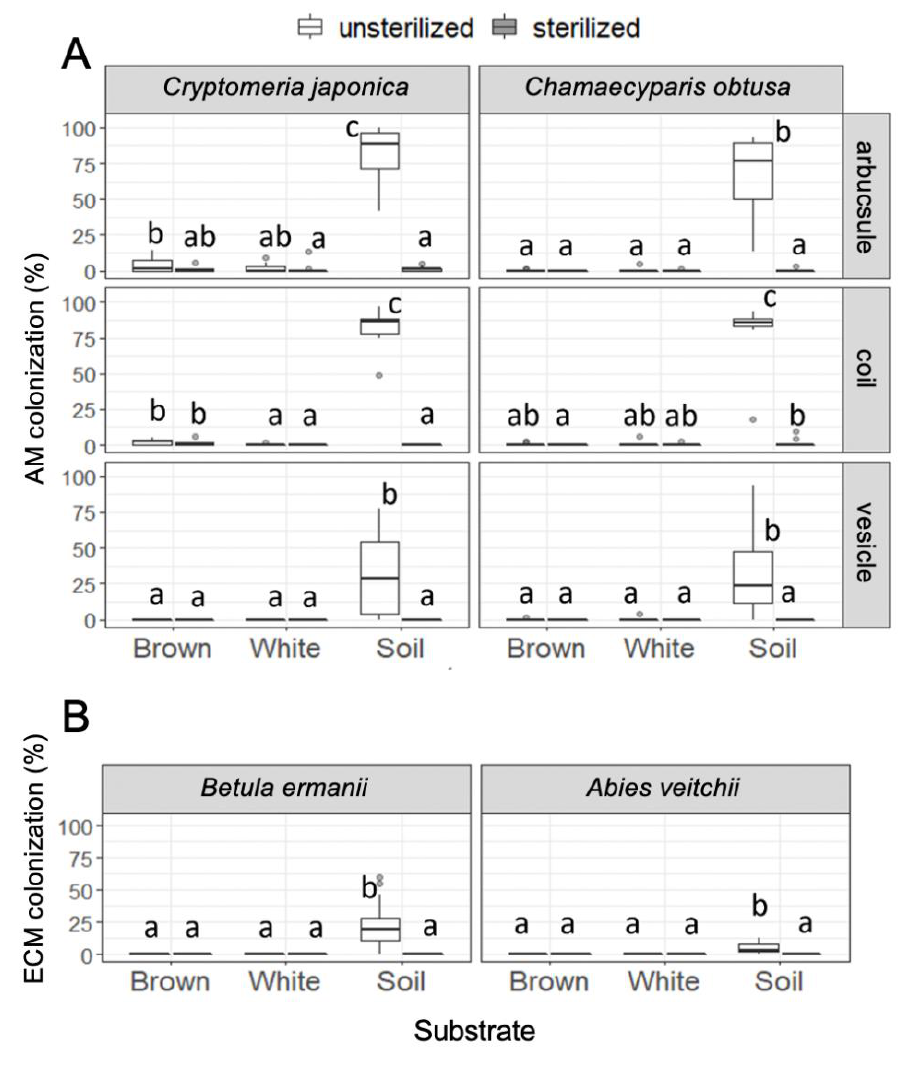
Figure 4. ( A ) Arbuscular mycorrhizal colonization in Cr. japonica and Ch. obtusa roots and ( B ) ecto- mycorrhizal colonization in B. ermanii and A. veitchii roots in unsterilized and sterilized substrates (brown rot wood, white rot wood, and soil). Different letters indicate significant difference among the six substrates ( p < 0.05, Permuted Brunner–Munzel test with Holm adjustment of probability values). n = 15 except for A. veitchii ( n = 8).